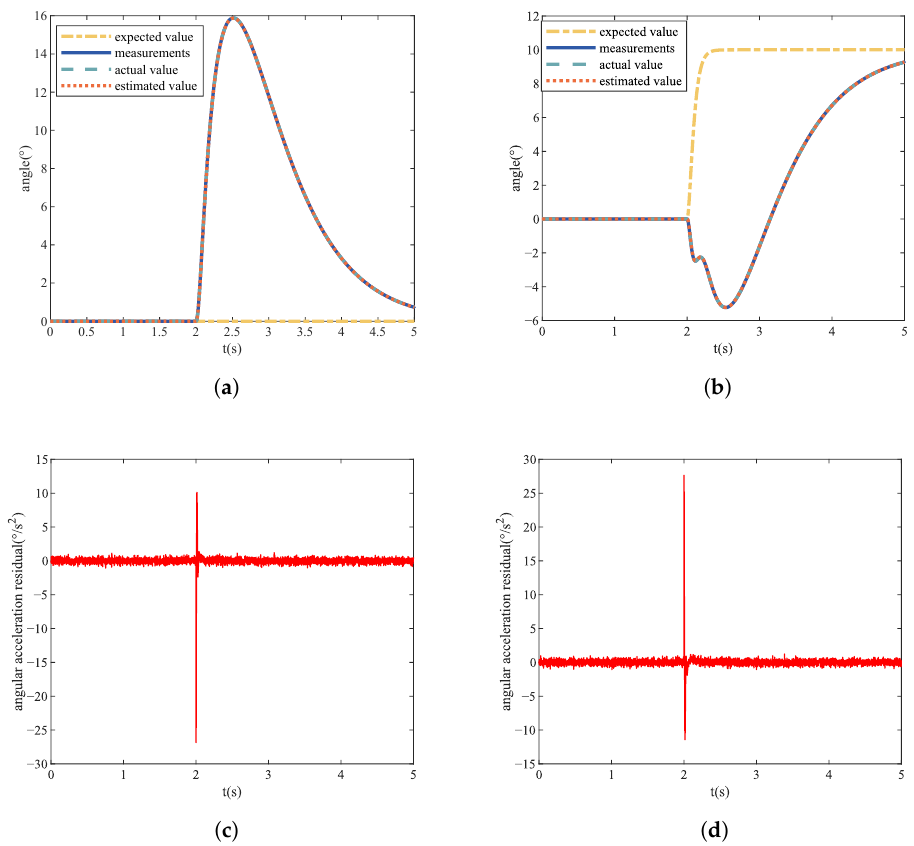
Figure 6. No. 1 actuator constant deviation fault. ( a ) Pitch angle signal value. ( b ) Roll angle signal value. ( c ) Pitch angular acceleration residual signal. ( d ) Roll angular acceleration residual